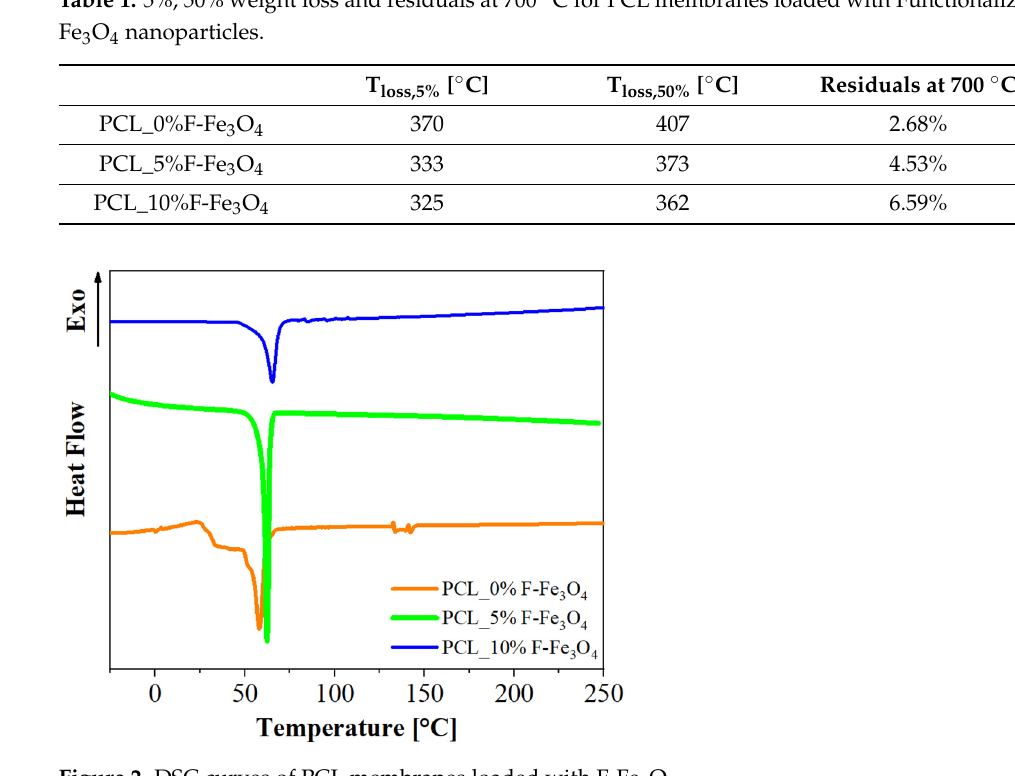
Table 1. 5%, 50% weight loss and residuals at 700 °C for PCL membranes loaded with Functional- ized Fe 3 O 4 nanoparticles.